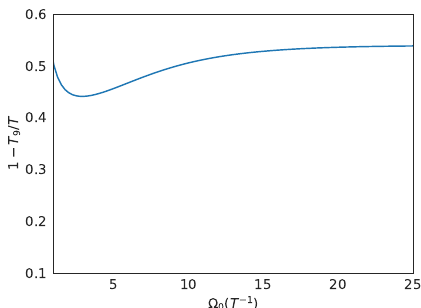
Figure 9. Quantity 1 − T 0.9 / T versus Ω 0 , where T 0.9 is the time needed so the population of level | 3 (cid:105) rises from p 3 ( t 1 ) = 0.01 to p 3 ( t 1 + T 0.9 ) = 0.9, for the shortcut with constant Ω ( t ) = Ω 0 and in the absence of